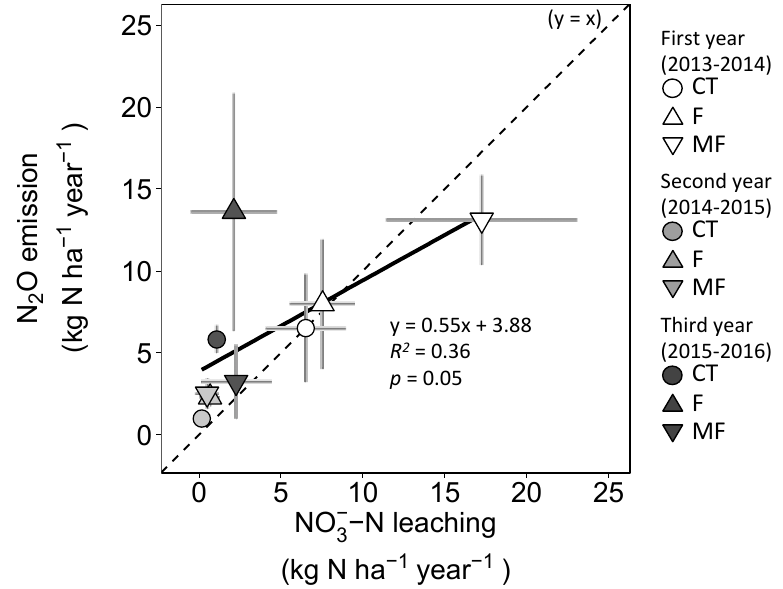
Figure 2. Relationship between annual N 2 O emission and NO 3 − –N leaching. CT is unfertilized control plots ( ○ ); F is chemical fertilizer plots ( △ ); MF is combined manure and chemical fertilizer plots ( ▽ ). Error bar represents standard deviation. The black solid line indicates a simple linear regression model for all values. The dashed line indicates the line of y = x .